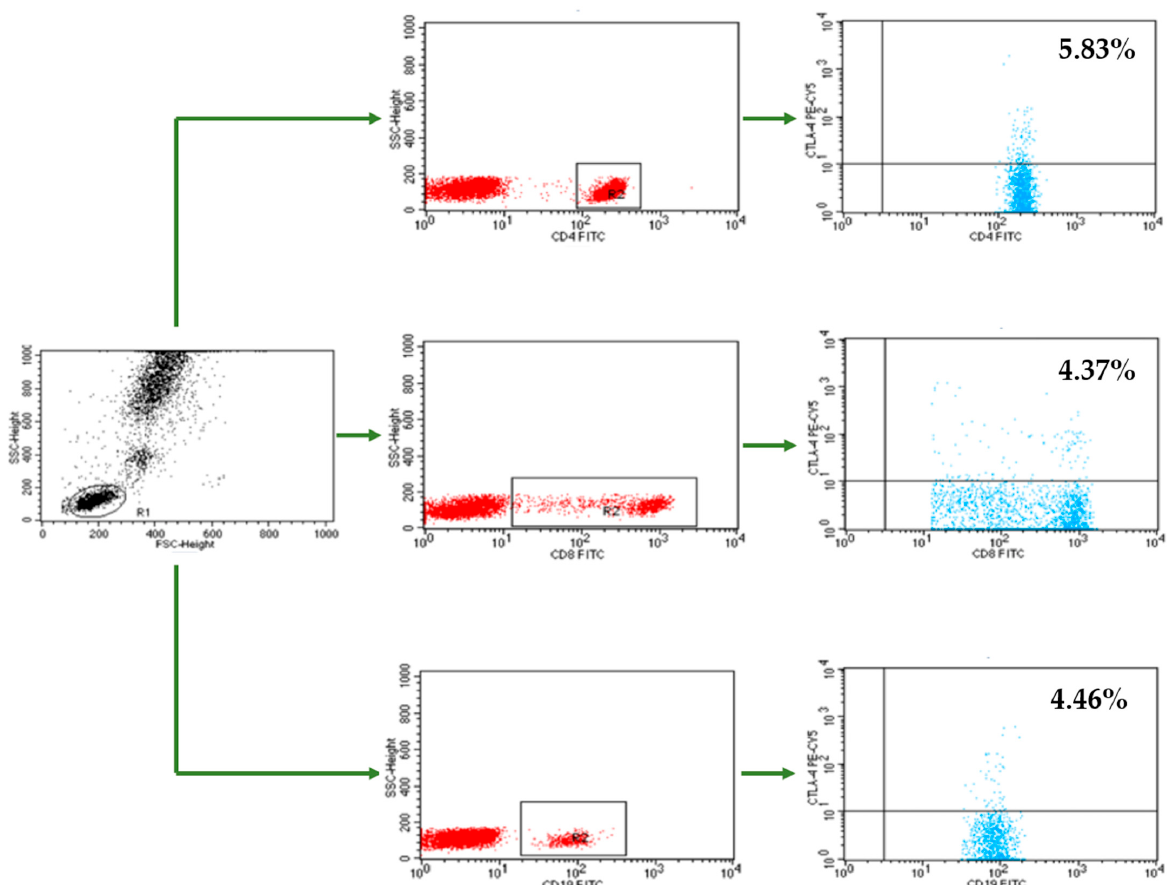
Figure 1. An example of flow cytometry analysis-assessment of the percentage of CD4+ T cells, CD8+ T cells and CD19+ B cells with CTLA-4 expression in patients with endometriosis. PBMCs from endometriosis patients were isolated and labeled as described in Immunophenotyping section. Scatter dot plots represent data from PBMCs in one endometriosis patient, analyzed by flow cytometry for CTLA-4 expression.